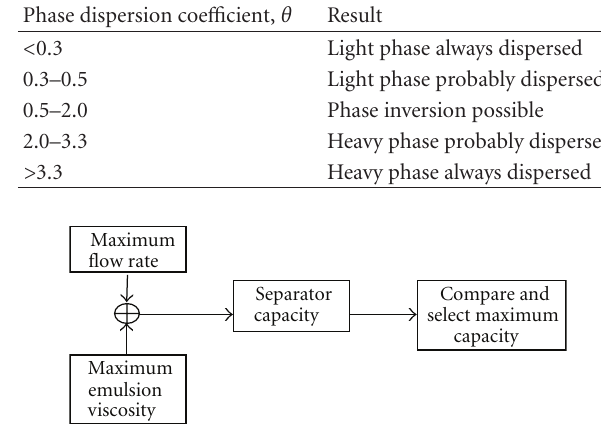
Figure 1: Separator sizing methodology.